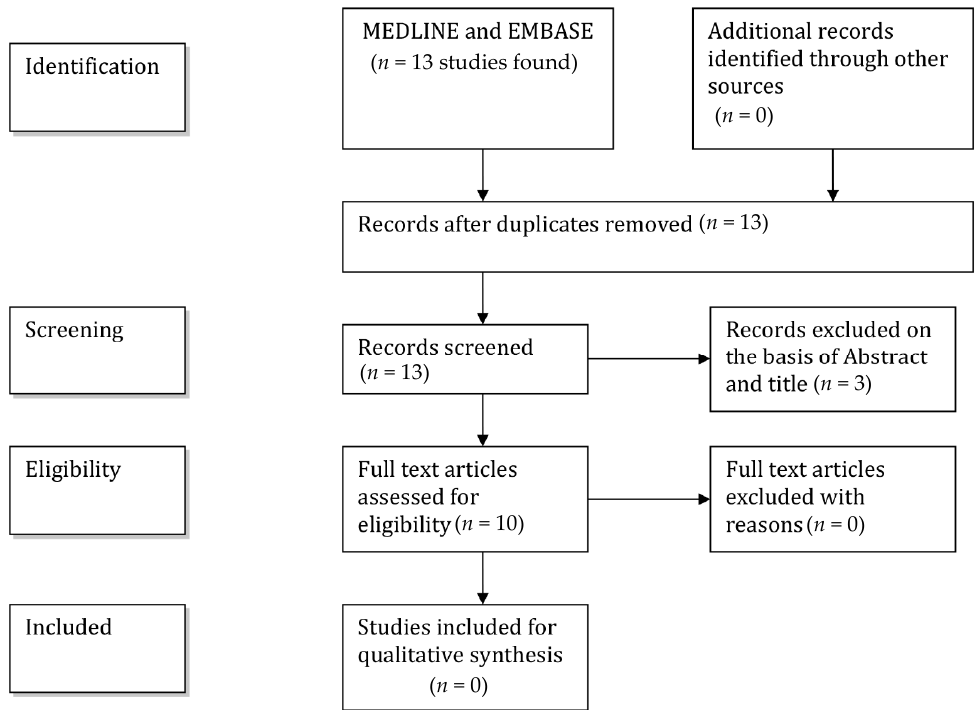
Figure 1. Flowchart showing the selection/inclusion process.